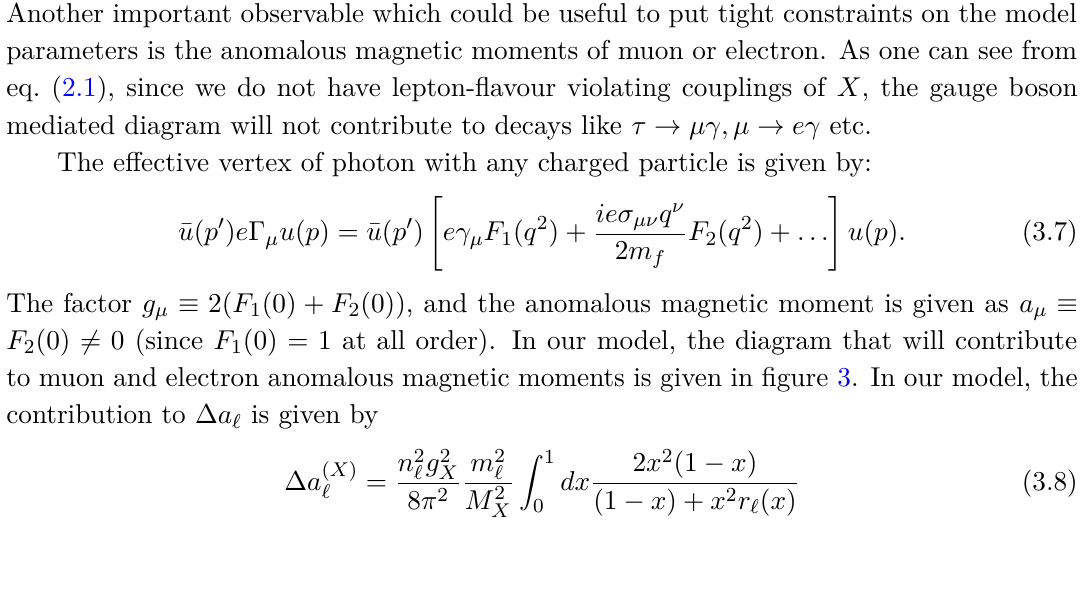
Figure 4 . The dependencies of the muon anomalous magnetic moment ( ∆ a µ ) on the different new physics model parameters. The red-dashed and solid lines represent the 3 σ lower limit of the measured values of ∆ a µ given in eqs. (1.1) and (1.2),